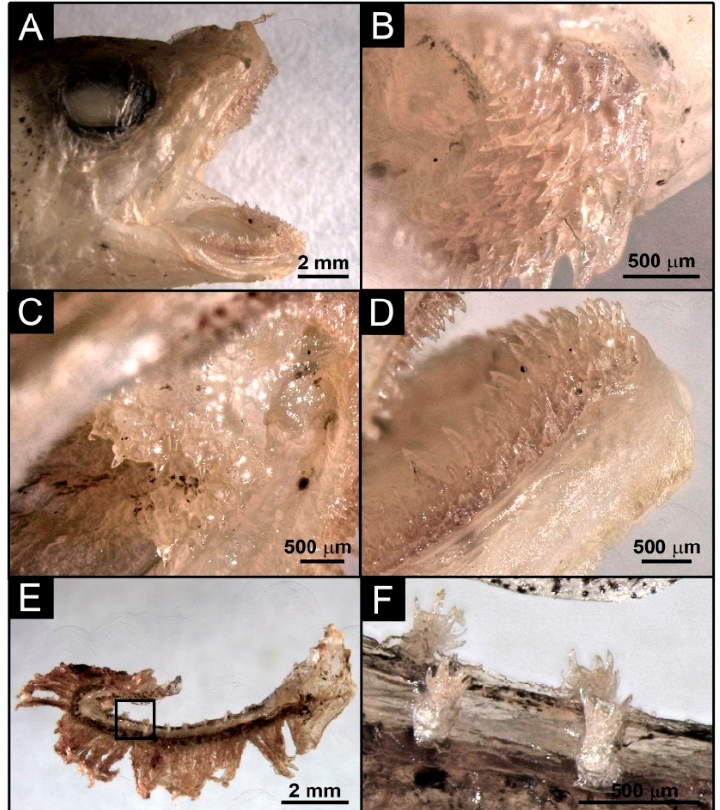
Figure 4. Details of the head structures of the holotype of Gaidropsarus gallaeciae sp. nov.: ( A ) mouth; ( B ) upper jaw teeth; ( C ) vomer teeth; ( D ) lower jaw teeth; ( E ) first gill arch; ( F ) gill rakers. Table 1. Morphological data of the type material of Gaidropsarus gallaeciae sp. nov.